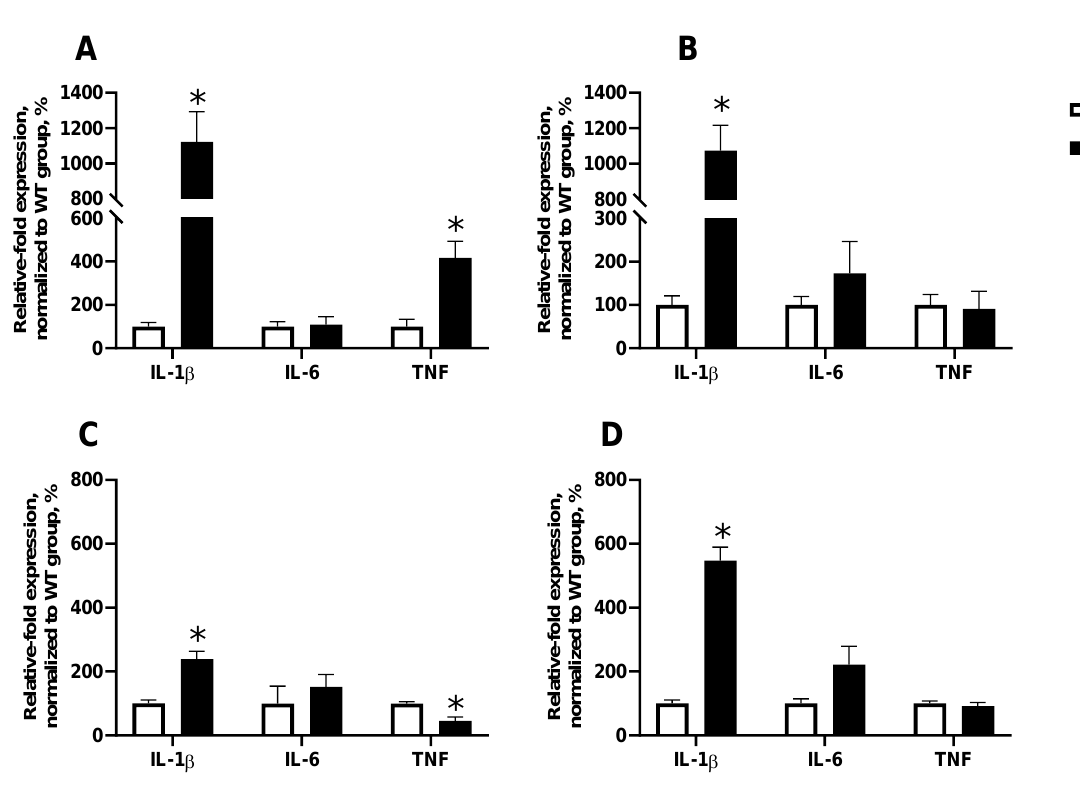
Figure 1. Expression of pro-inflammatory cytokines Il-1 β , Il-6 and TNF mRNA in ( A ) brains of male and ( B ) female St3gal5 − / − mice and ( C ) spleens of male and ( D ) female St3gal5 − / − mice. The expression of Il-1 β is significantly elevated in both the brain and spleen of both genotypes. Differential mRNA expression of TNF is observed in male and female mutants’ brains, with a significant increase in male mutants compared to controls and the opposite effect in females. Male and female St3gal5 − / − mice and their wild type littermates, n = 6–10 per group, aged 2–3 months, were housed under standard conditions. Mice were euthanized, perfused with saline, and their brains and spleens were dissected and frozen at − 70 ◦ C for qPCR assay. Full description of the study can be found in [57]; for primer sequences, see [56]. WT—wild-type mice. * p < 0.05 vs. control (wild-type) mice. Data are presented as Mean ± SEM.